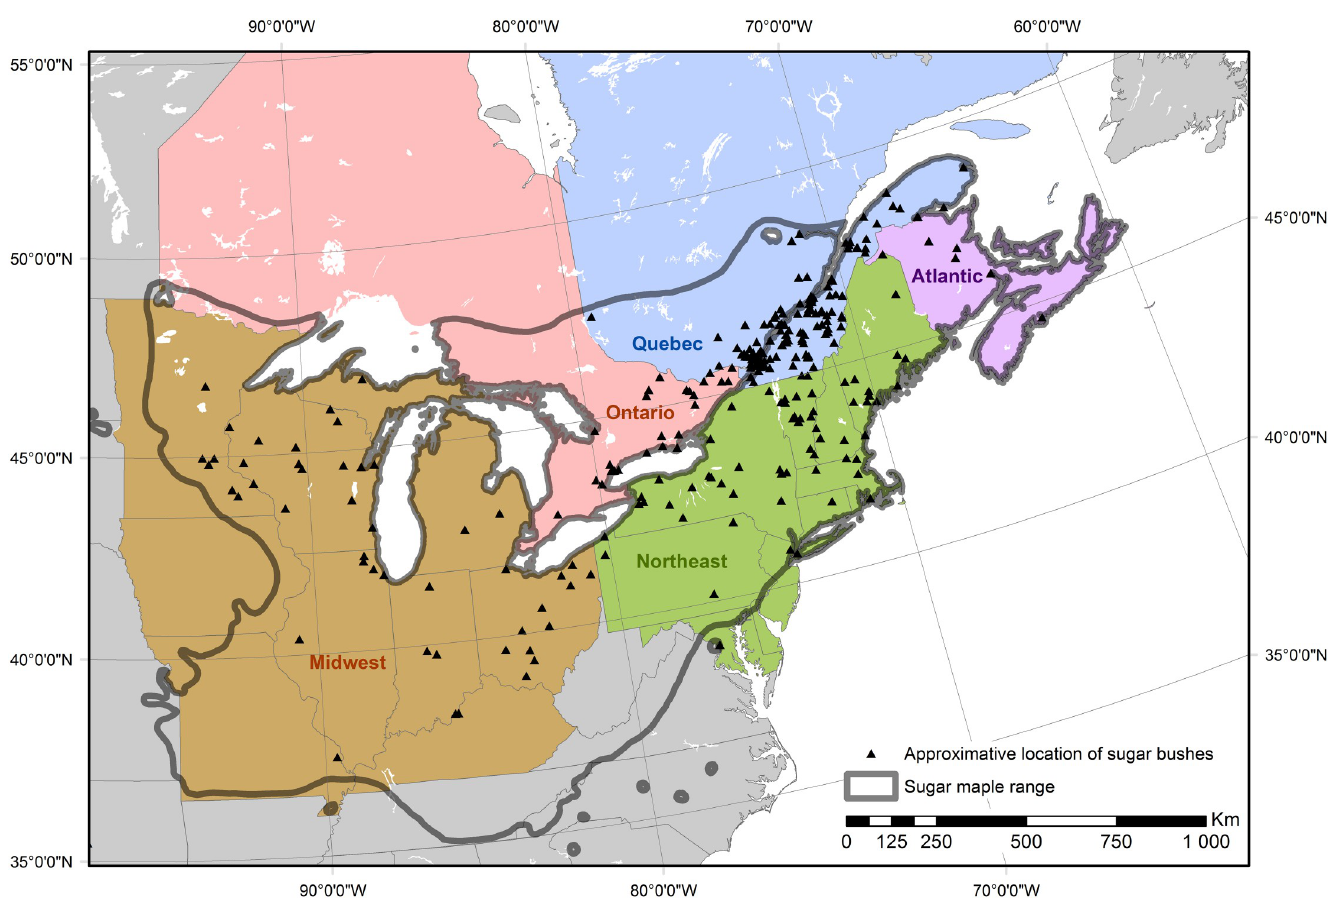
Fig 1. Study area. Sugar maple range (adapted from [18,19]), maple syrup regions as defined by Murphy et al. [20], and approximate location of sugar bushes whose owners participated in the survey presented in this document. The locations are based on the postal code provided by the respondents and do not necessarily represent the exact location of their sugar